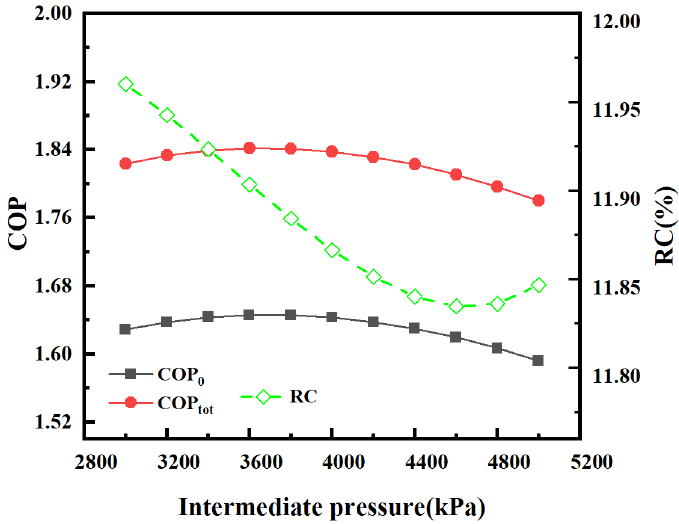
Figure 6. COP of the coupling cycle and CO 2 cycle varied with the intermediate